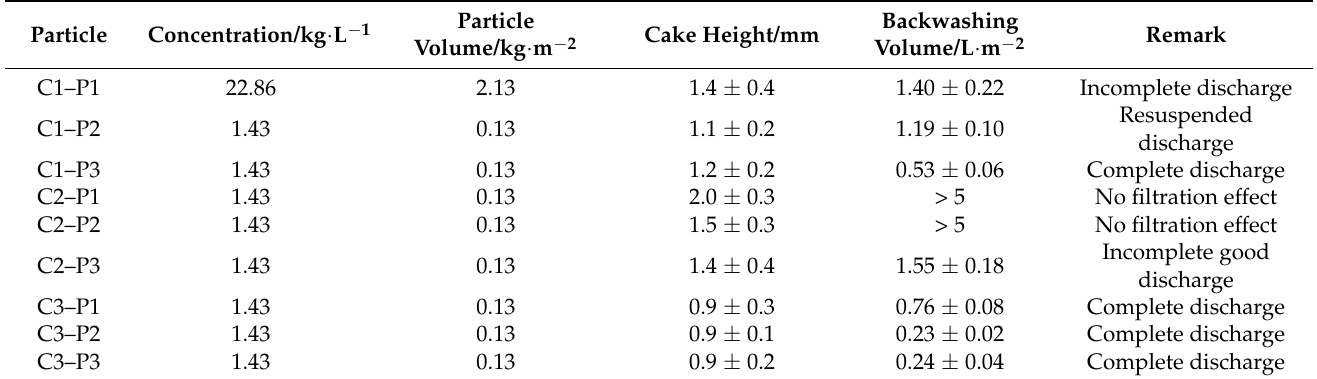
Table 2. Cake height and backwashing volume at a cellulose quantity of 0.13 kg · m − 2 (option 1) with the respective particle systems at a backwashing pressure of 0.5 bar.